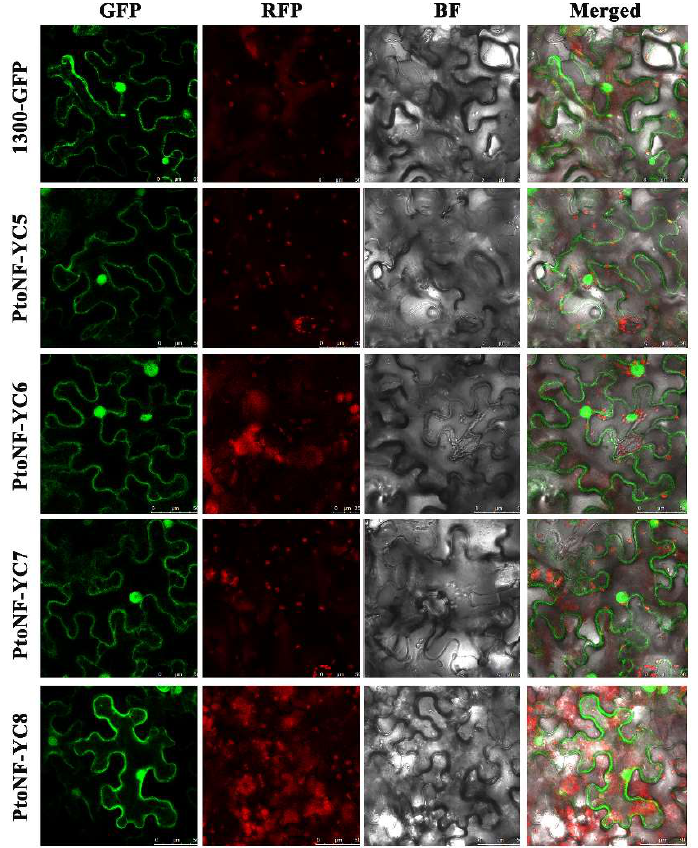
Figure 3. Subcellular localization of pSuper1300-GFP-PtoNF-YC5/6/7/8 proteins. From left to right, GFP, RFP, BF, and Merged represent the GFP signal, chloroplast spontaneous signal, bright field, and superimposed signal, respectively, bar 50 μm .